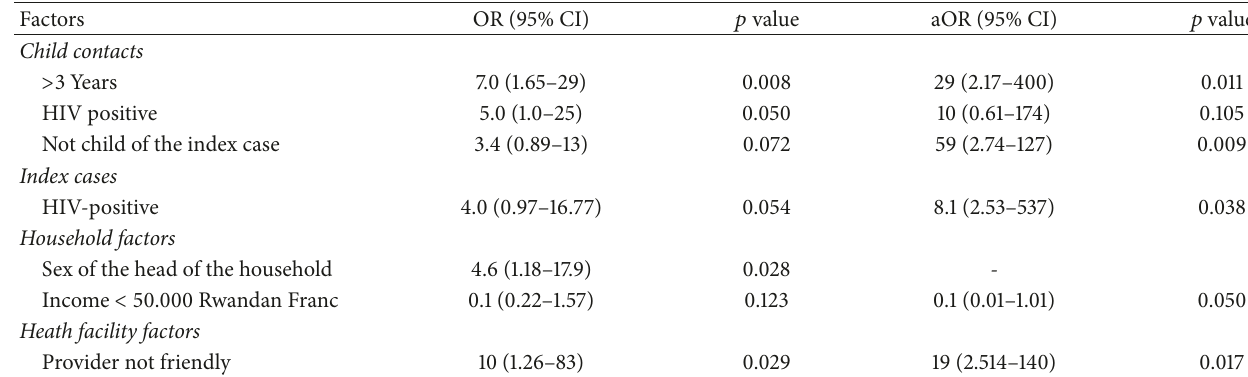
Table 4: Risk factors for nonuptake of